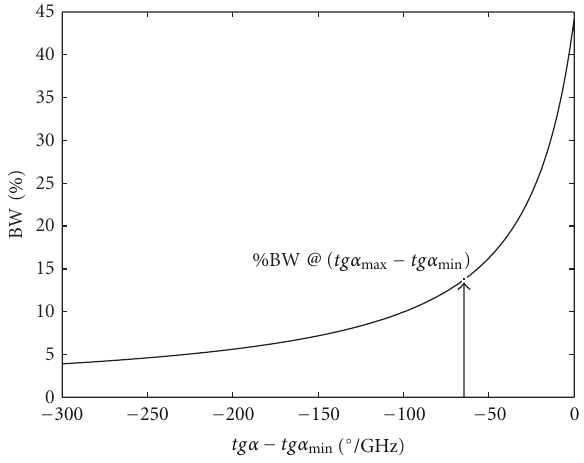
Figure 6: Percent bandwidth estimation for a 28 GHz reflectarray ( D = 14 λ 0 − F/D = 0 . 69) at a fixed phase curve slope.